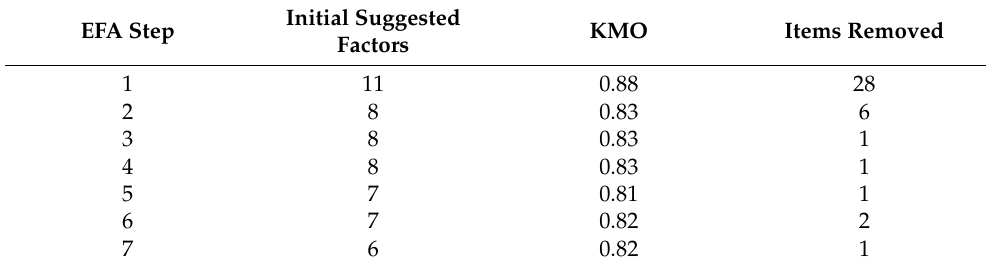
Table 4. EFA steps.